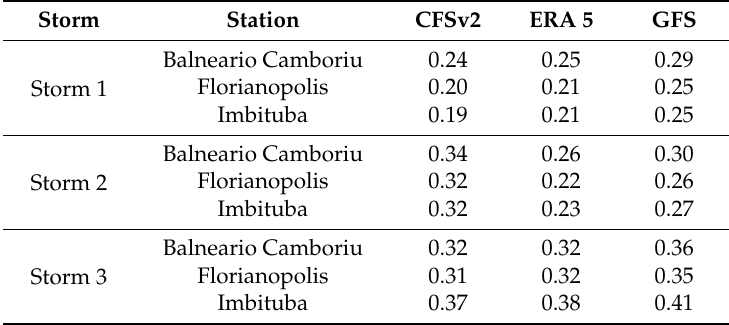
Table 1. Total water level error metrics (RMSE in m).